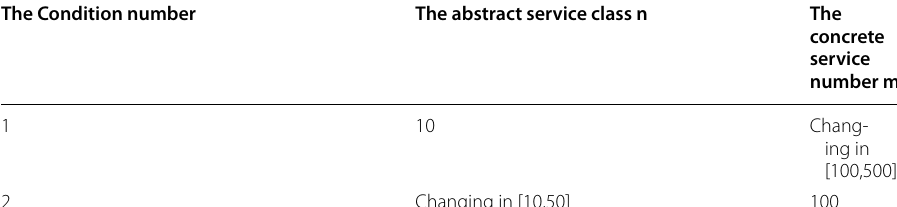
Table 2 Simulation Setting of abstract service class n and concrete service number m The Condition number